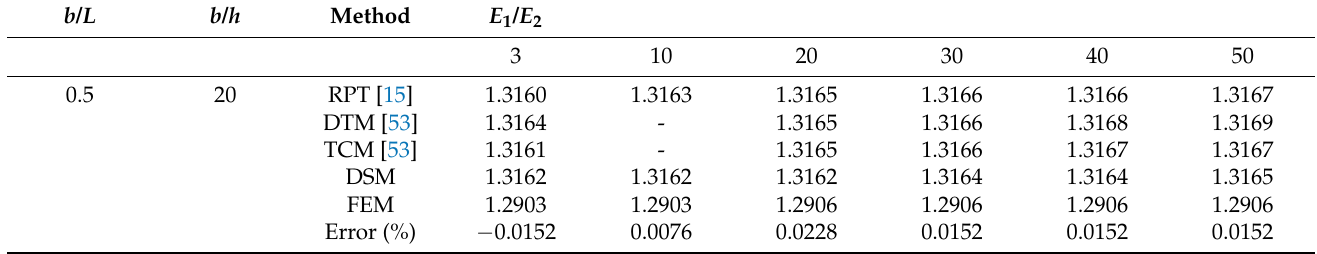
Table 5. Comparison of the fundamental frequency parameters plate with the SF boundary